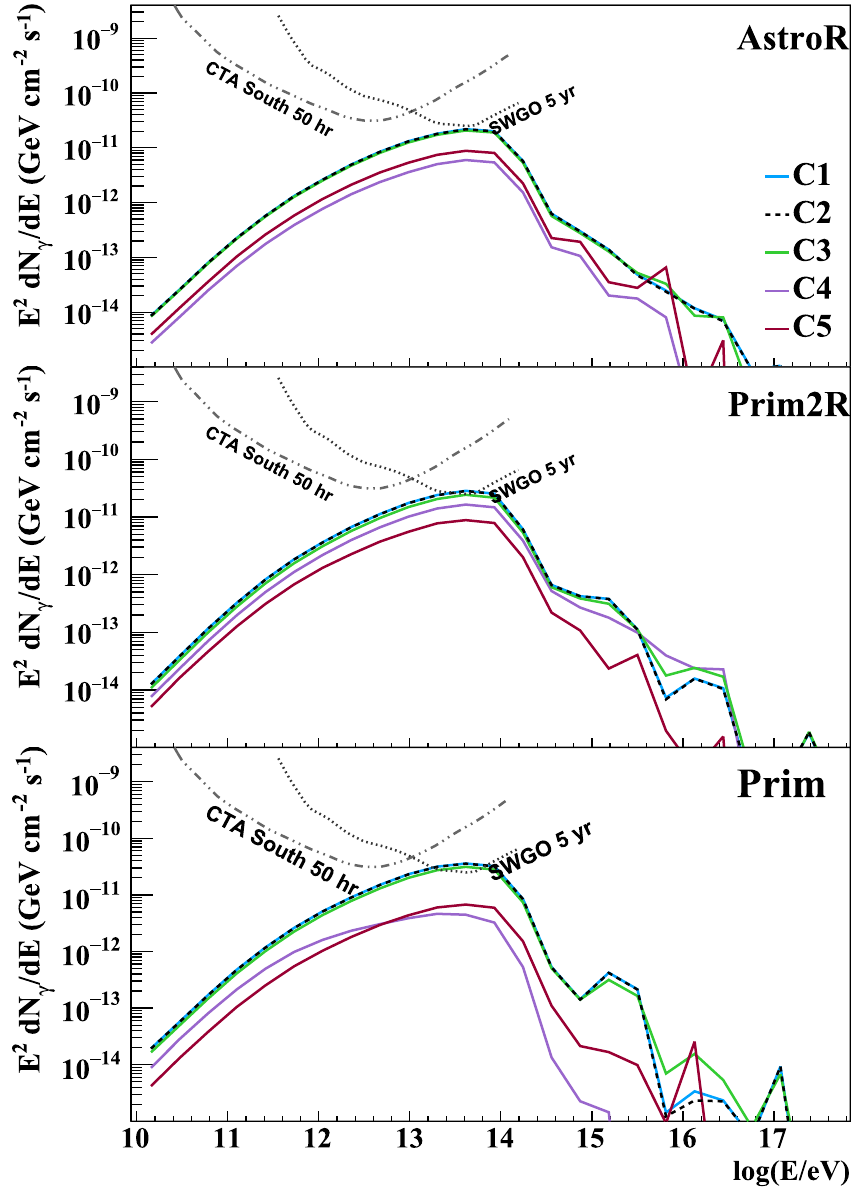
Fig. 8 Flux of secondary gamma-rays as a function of energy. Three EGMF are shown: AstroR, Prim2R and Prim. Each curve corresponds to a composition abundance: C1–C5. The sensitivity of